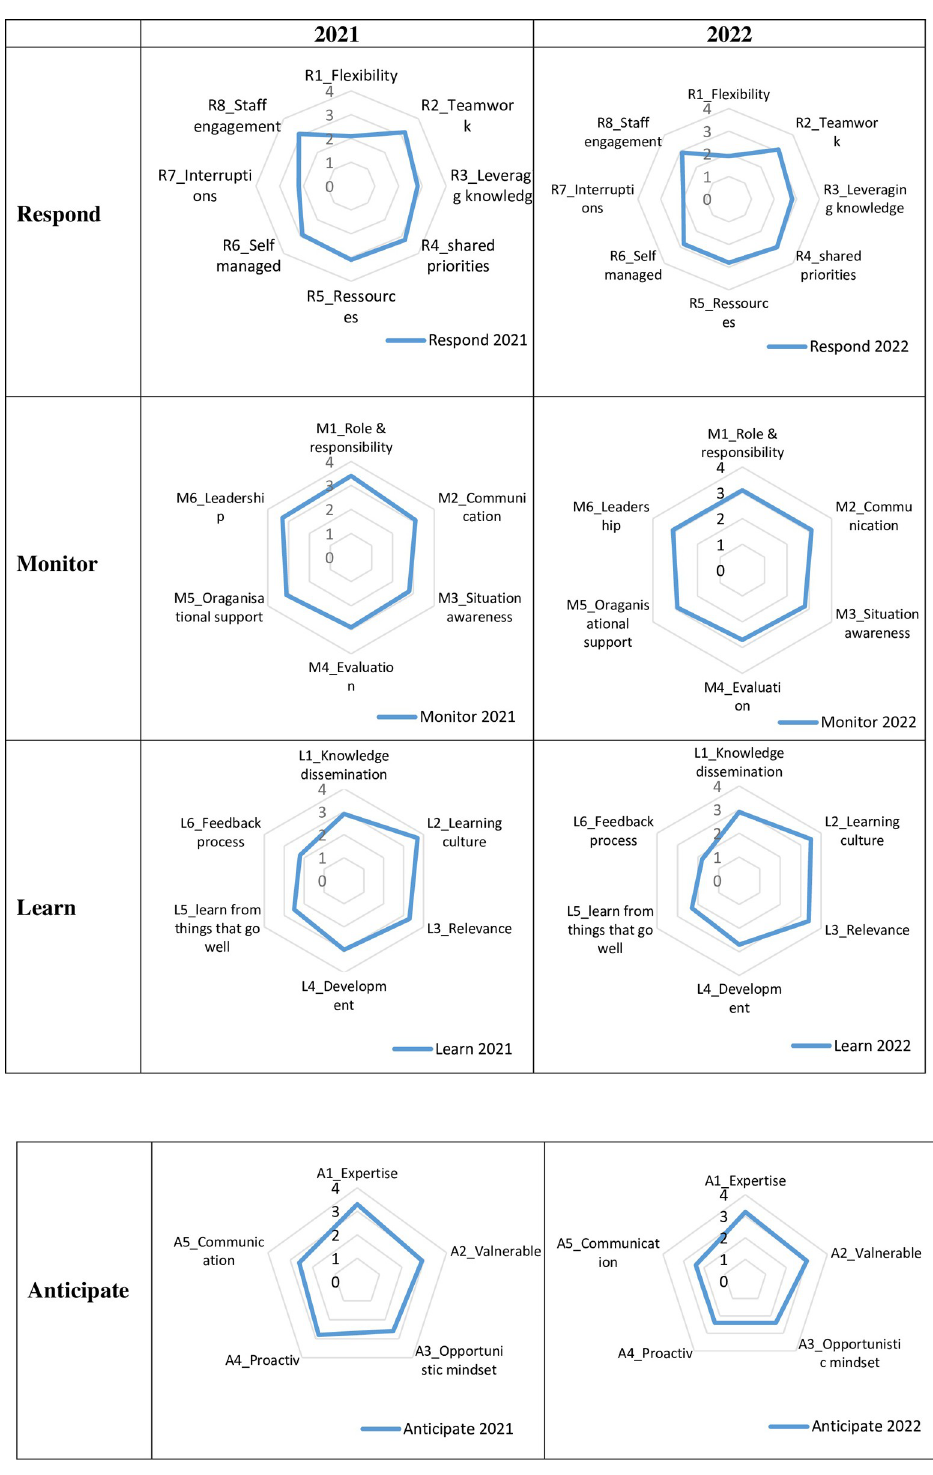
Fig 3. Resilience profile of the internal medicine department in 2021 and 2022.